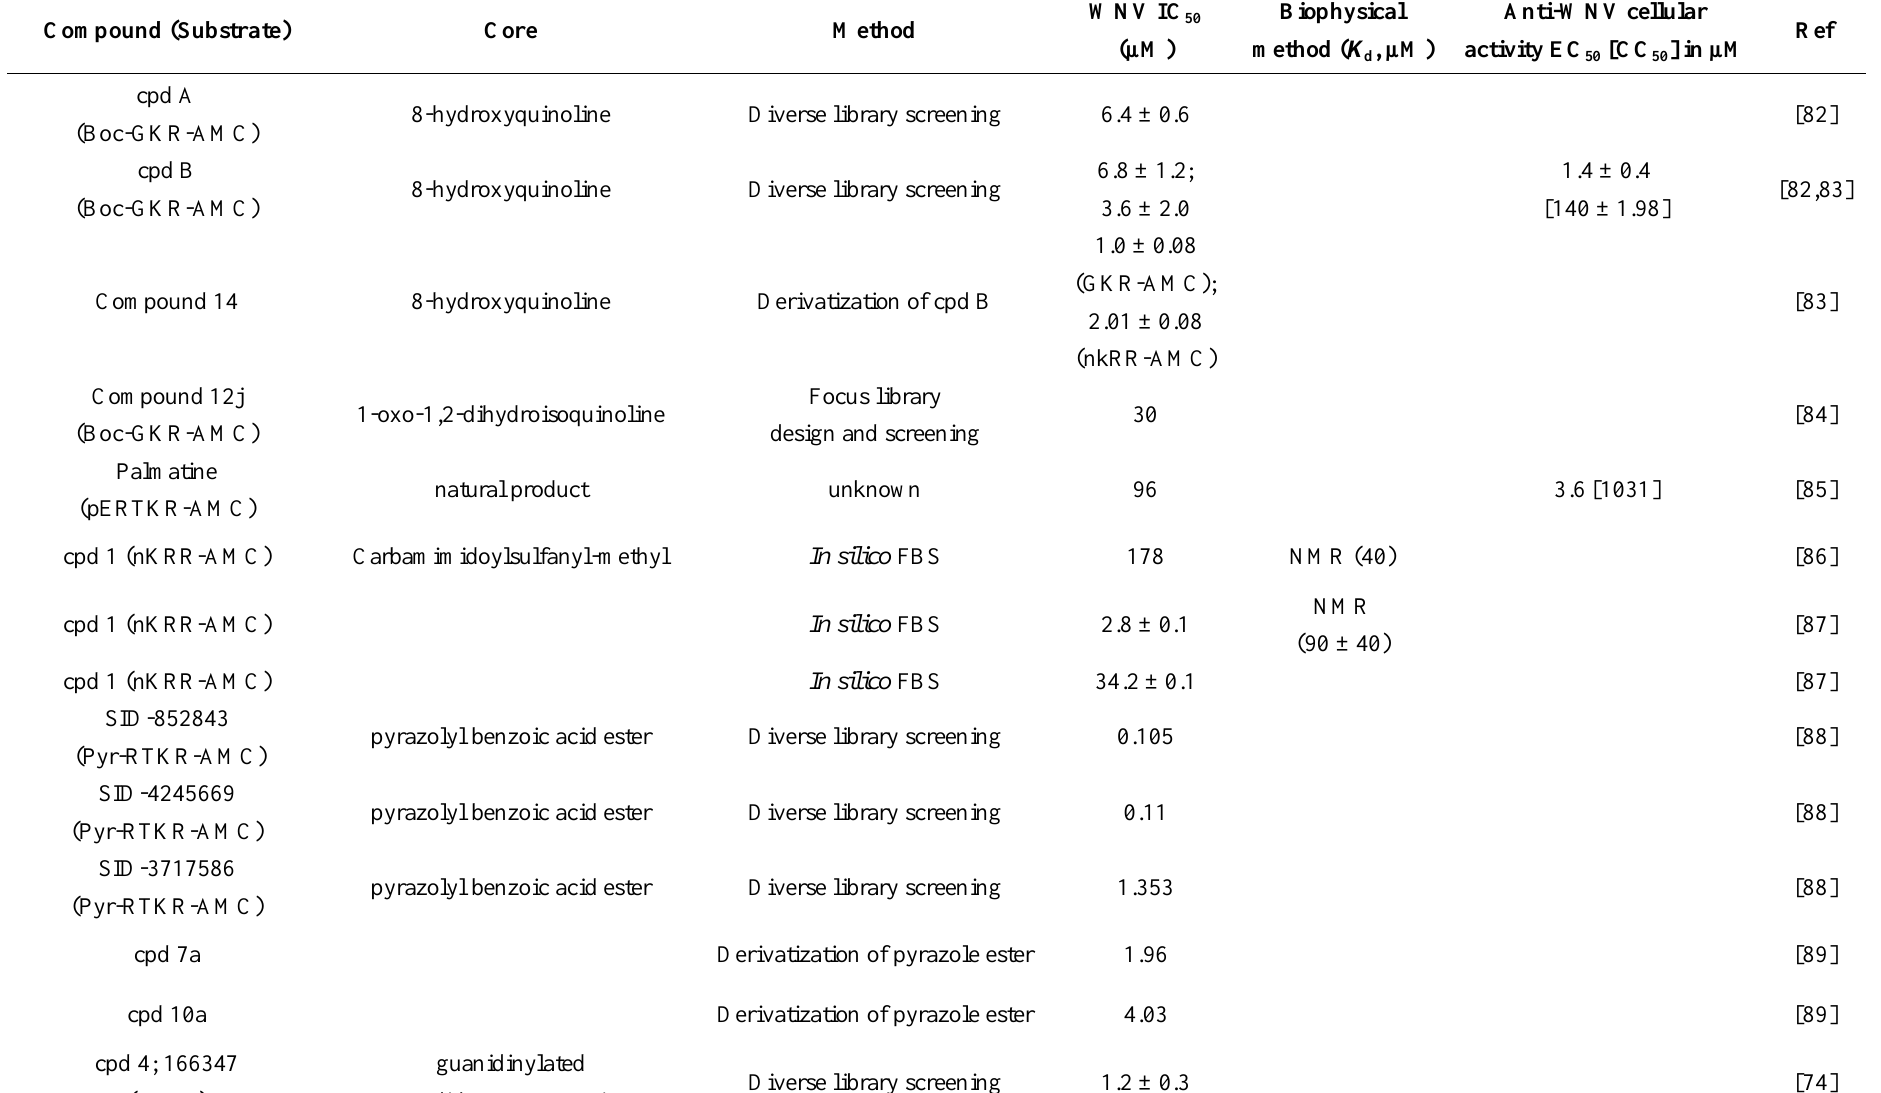
Table 2. List of WNV NS2B/3pro non-peptidic